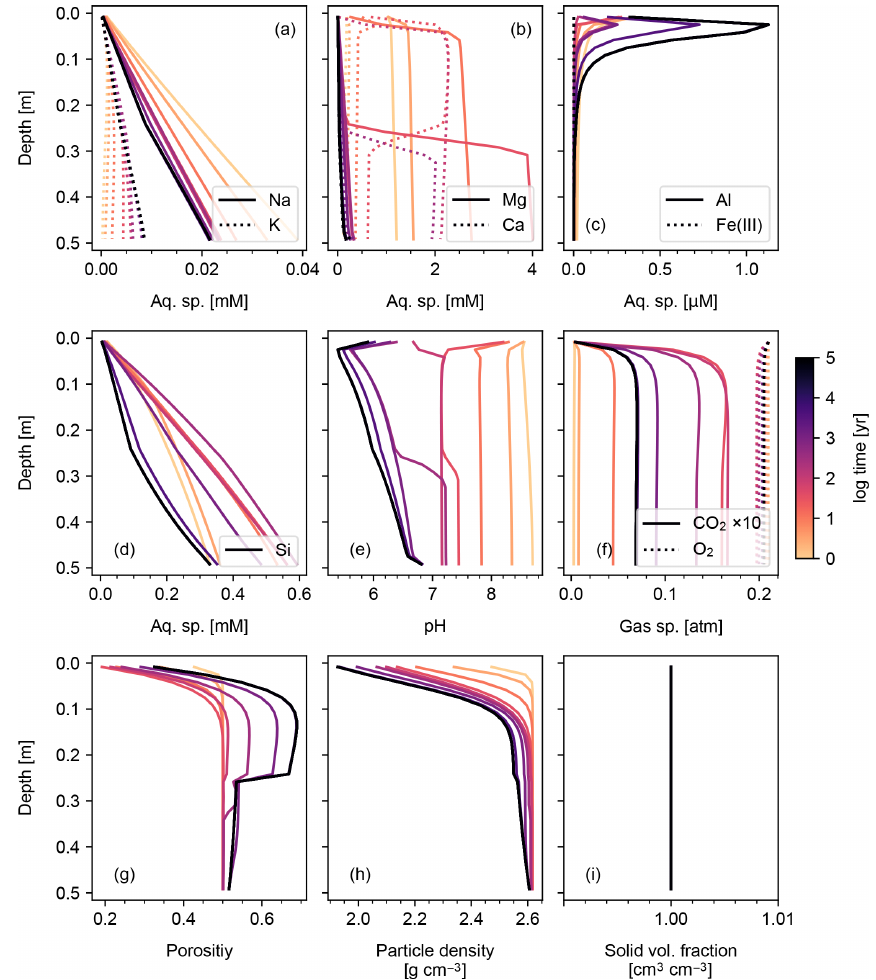
Figure 7. Simulation of biotic weathering at Site 1 in Table 8. Panels show the depth profiles of aqueous and gas species and soil physical properties as in Fig. 4 except that simulation includes soil respiration and